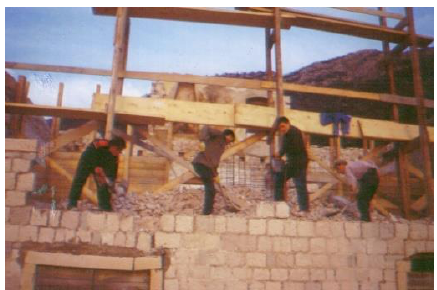
Figure 32. The façade had to be taken down due to the forced protrusion.